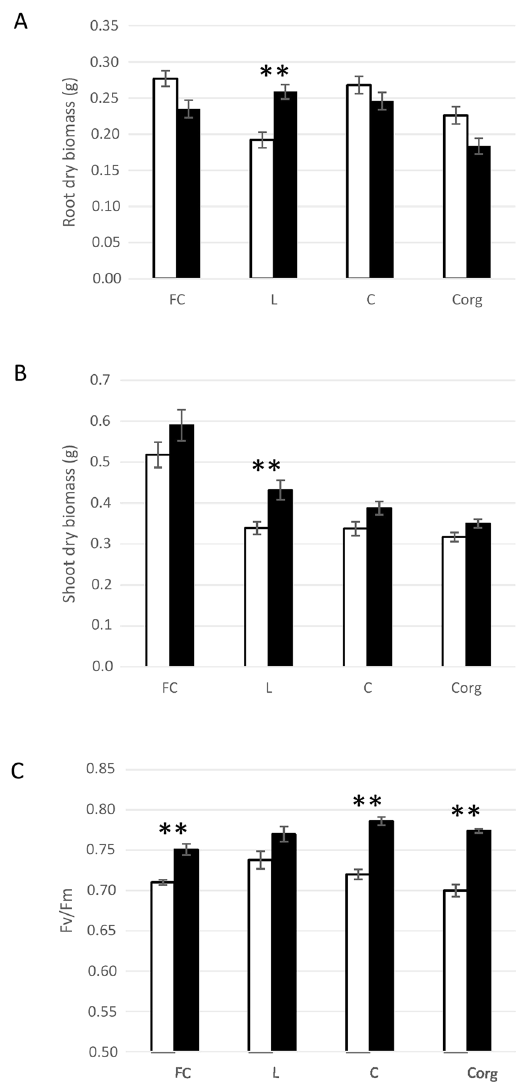
Figure 3. Roots ( A ), shoot ( B ) dry biomass and photosynthesis efficiency ( C ) under differing field and bacterial seed-coating conditions. Measurements were made on mock-inoculated (white bars - NI) or A . lipoferum CRT1-inoculated (black bars - I) 6-leaf stage plants of all fields (FC, L, C and Corg). Results are expressed as mean ± SE (n = 20). Statistical tests (two-by-two Wilcoxon tests) were conducted to determine significant differences among the 2 conditions (NI and I) and are indicated with stars: * p < 0.05, ** p <